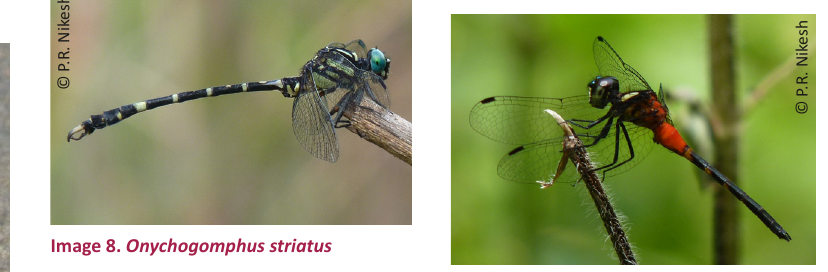
Image 9. Epithemis mariae